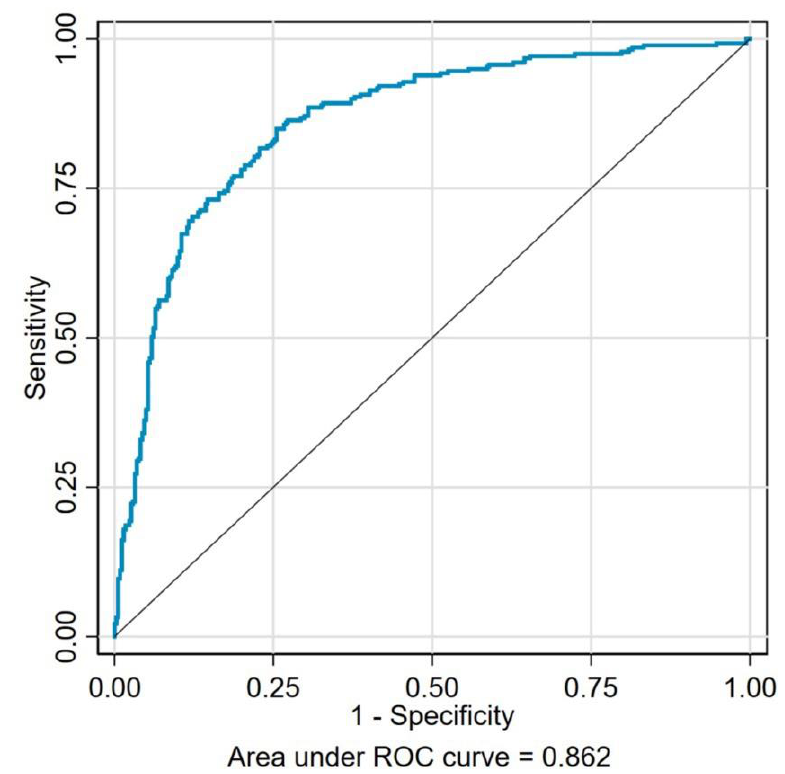
Figure 2. The receiver operating characteristics for seven risk factors (high education level, physical inactivity, neuropathy, retinopathy, low hemoglobin concentration, CKD stages 3–4, and a poor QOL) combined to predict anxiety in the DKD patients. The area under the curve was 0.862.